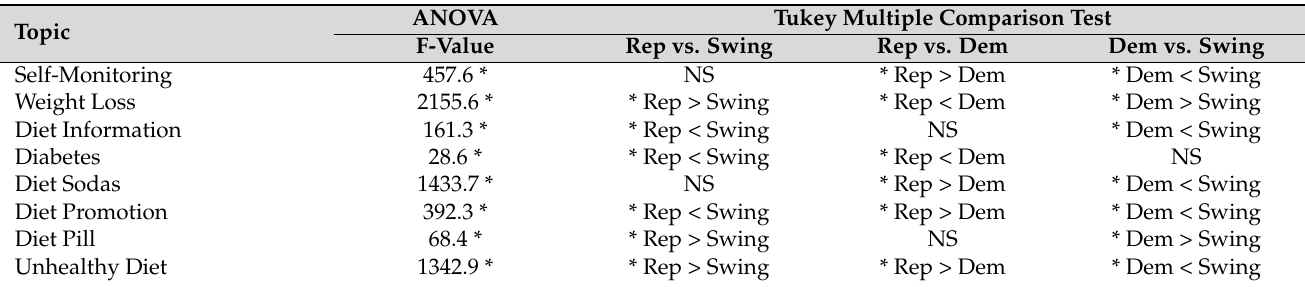
Table 2. Comparison of democratic (Dem), republican (Rep), and swing states. Not significant (NS): adjusted p -value > 0.0005, significant (*): adjusted p -value ≤ 0.0005.